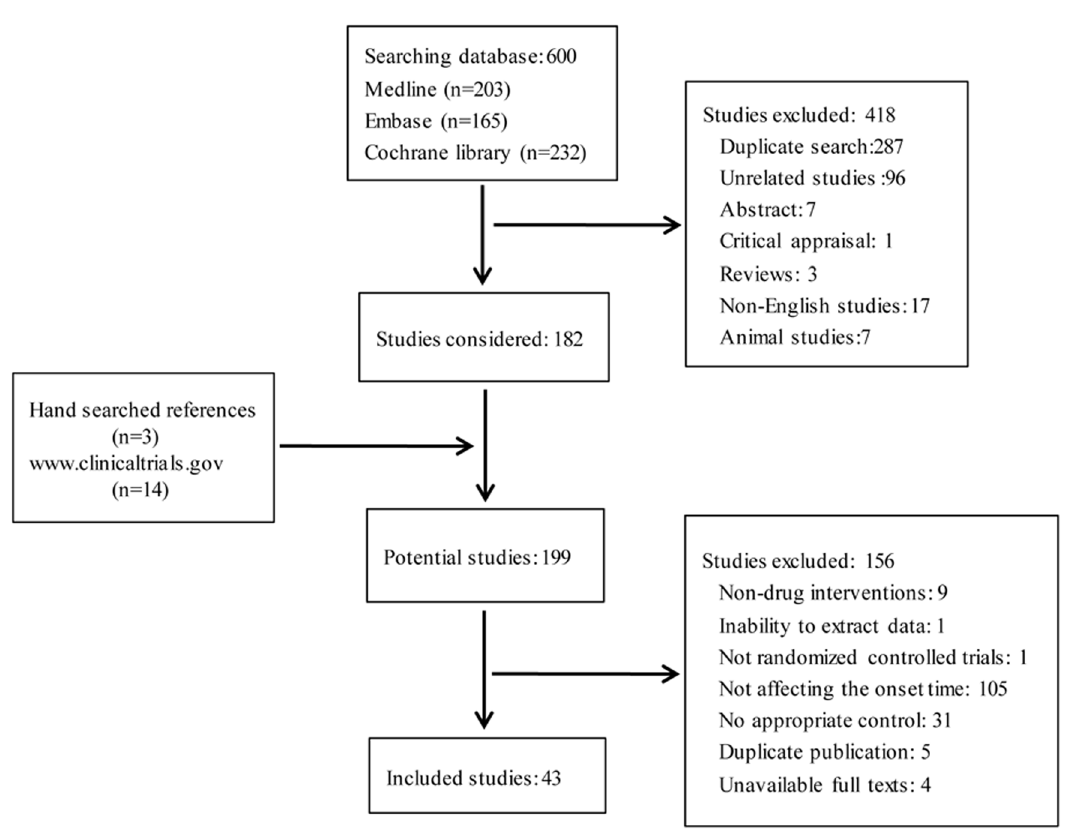
Figure 1. PRISMA flow